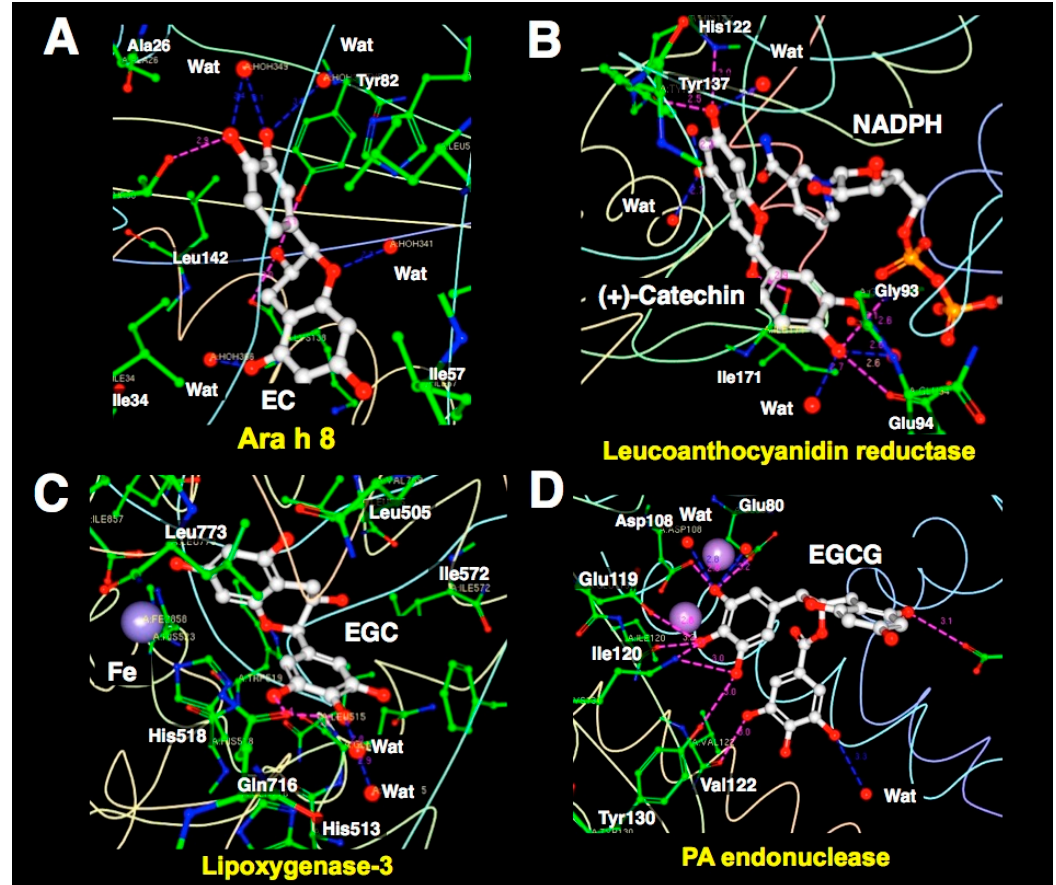
Figure 10. Representative interactions of EGCG or ECG with proteins as revealed by XCA. ( A ): Ara h 8 complex with EC. The residues that form hydrophobic interactions are not displayed. ( B ): Leucoanthocyanidin reductase complex with (+)-catechin and NADPH. The residues that form hydrophobic interactions are not displayed. The nicotinamide and the C ring of ECG stack in parallel. ( C ): Soybean lipoxygenase-3 complex with iron and ECG. The residues that form hydrophobic interactions are also displayed in a wire-frame model. Hydrophobic contact is defined by the number of atoms within 3.9 Å of the ligands. ( D ): PA endonuclease complex with EGCG. Extensive hydrogen bonds observed in PA endonuclease. The residues that form hydrophobic interactions are not displayed. The red dotted lines represent the observed hydrogen bonds (within 3.3 Å). The blue dotted lines represent bridged hydrogen bonds. Figures were prepared using RCSB PDB Ligand Explorer software.